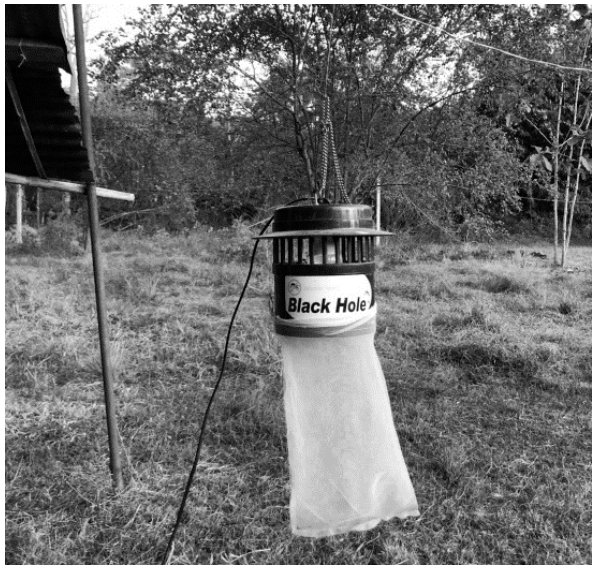
Figure 1. Mosquito traps (Black Hole™ Mosquito Trap, Bio-Trap Inc., Seoul, Korea) used in this study were purchased from Pan Science Co., Ltd., Bangkok, Thailand.